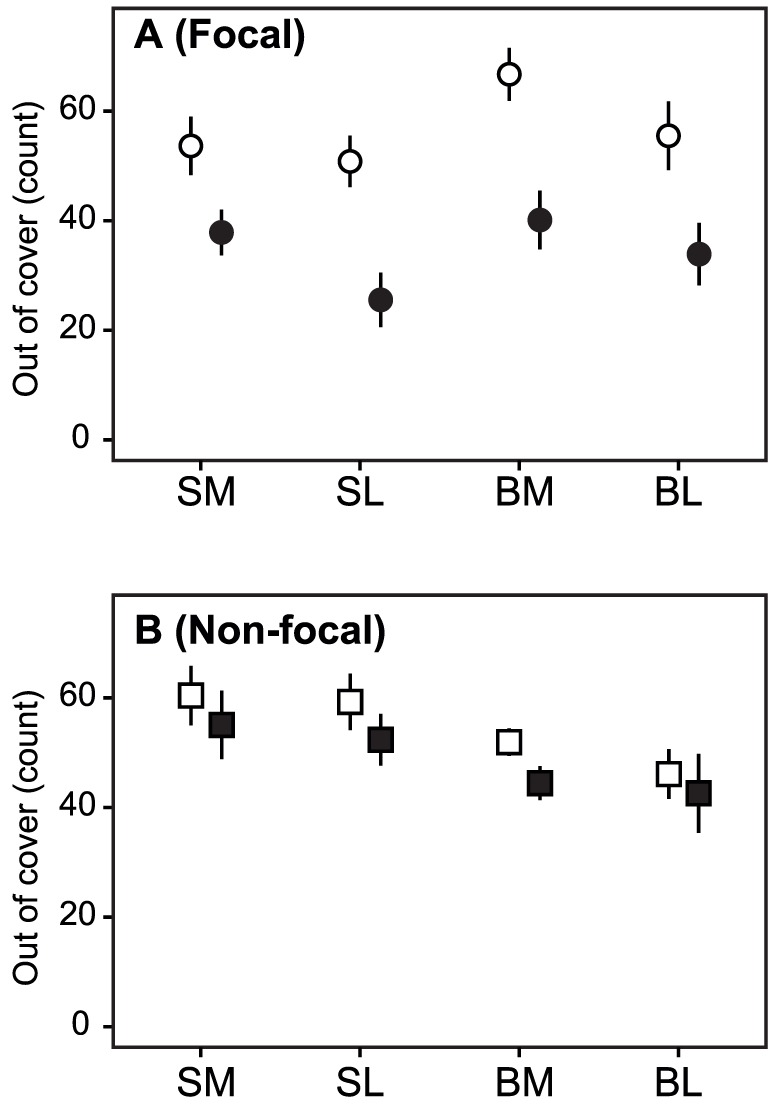
Numbers of trips out of cover (irrespective of whether alone or joined by the partner).(A) Focal fish and (B) non-focal fish. SM: focal fish are moderately shyer than their partner before satiation, SL: focal fish greatly shyer than their partner, BM: focal fish moderately bolder than their partner, BL: focal fish greatly bolder than their partner. Open symbols indicate before satiating focal fish, and filled symbols indicate after satiating focal fish. Values are mean ± SE.